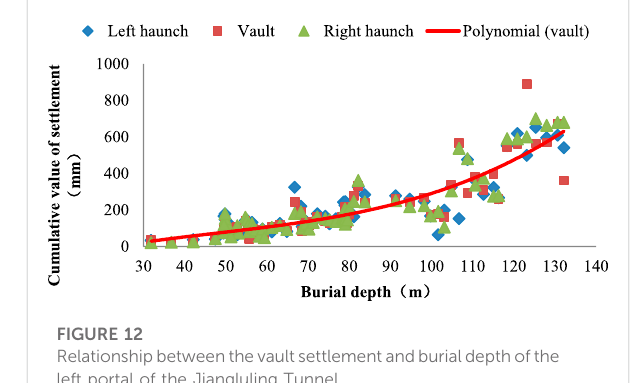
FIGURE 10 Deformation diagram of the surrounding rock at Cross-section YK330+920.